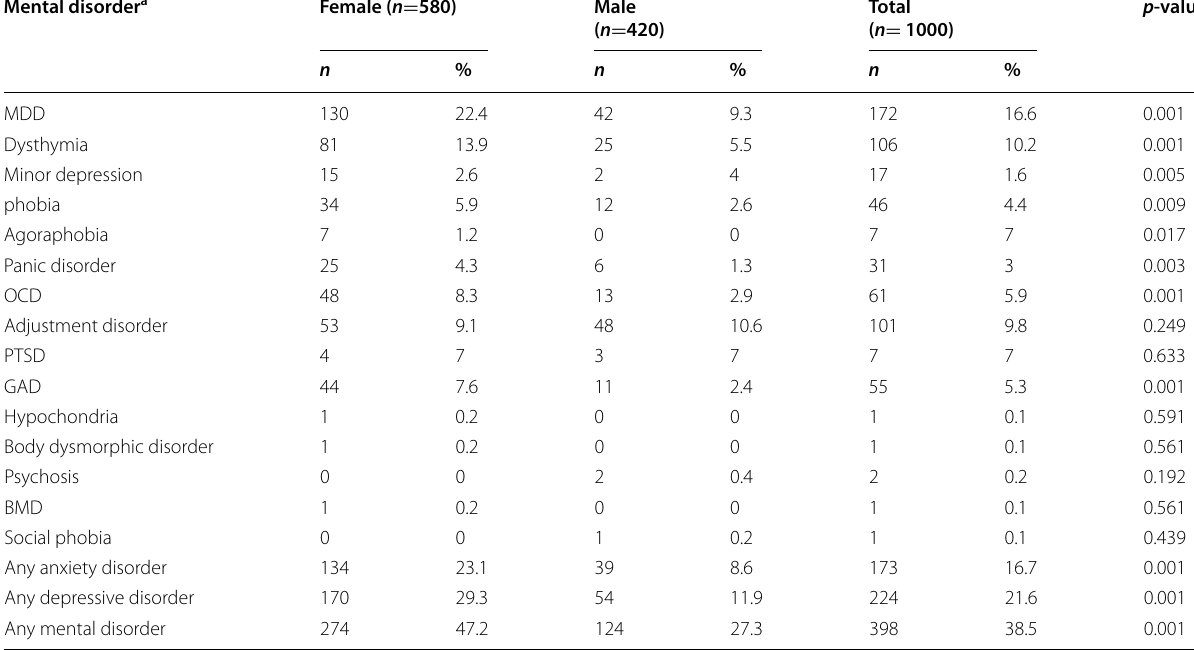
a Some participants had more than one disorder. Therefore, the total number of disorders was more than the total number of participants